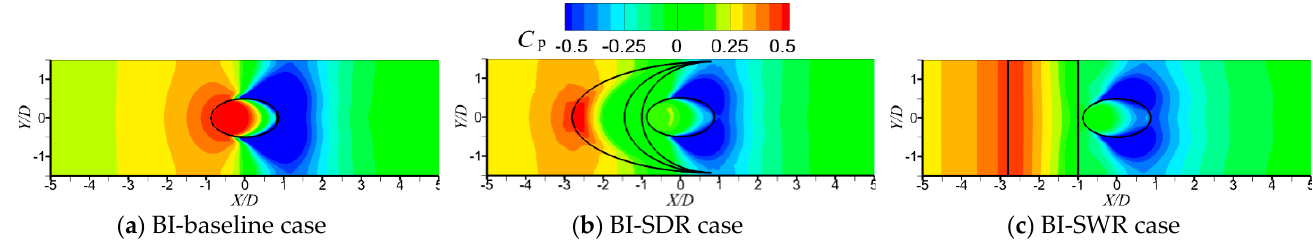
Figure 7. Static gauge pressure contours on a horizontal plane of Z/D = 0.125 in BI cases.